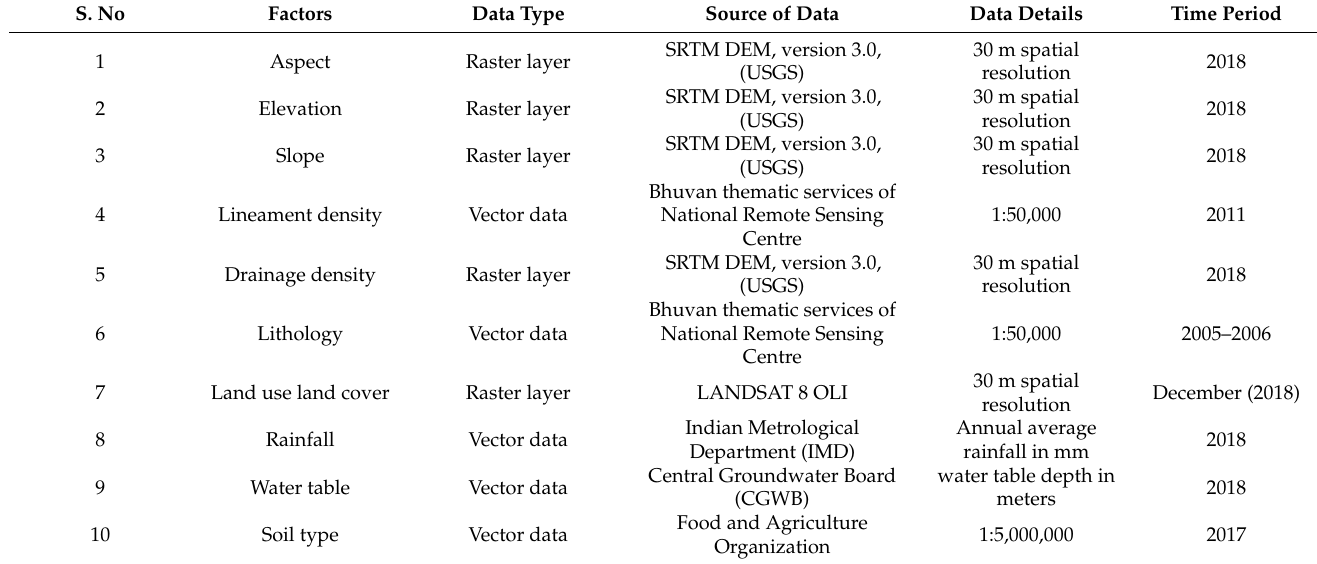
Table 1. Description of dataset used for groundwater potential zonation